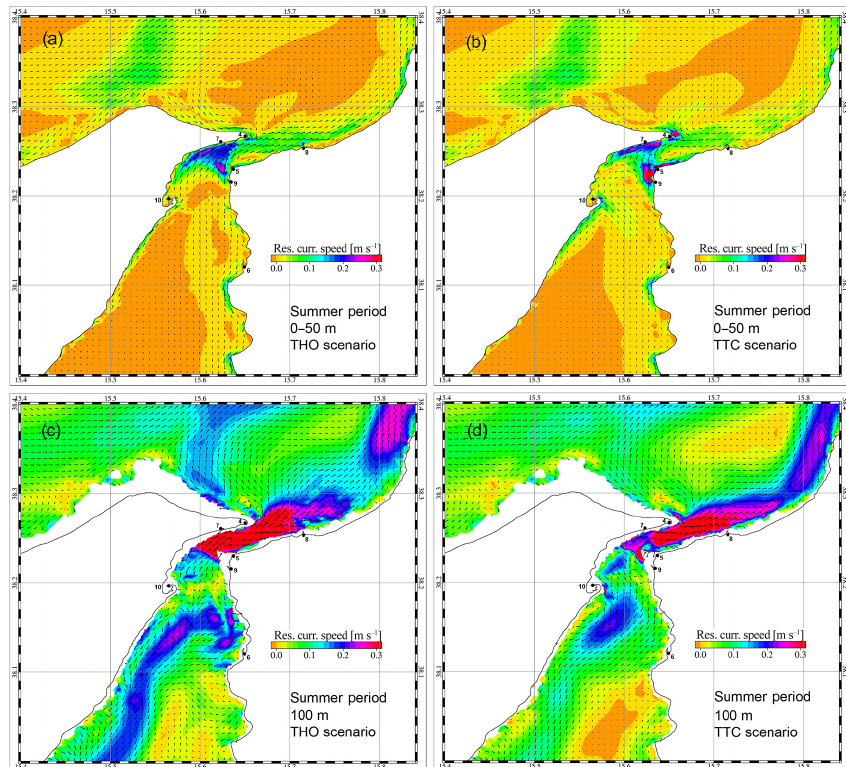
Figure 5. Computed summer residual current field from the THO scenarios results ( a and c ) and from the TTC scenario results ( b and d ). Upper panels refer to average residual velocities computed between 0 and 50m ( a and b ). Bottom panels refer to residual velocities at 100m depth ( c and d